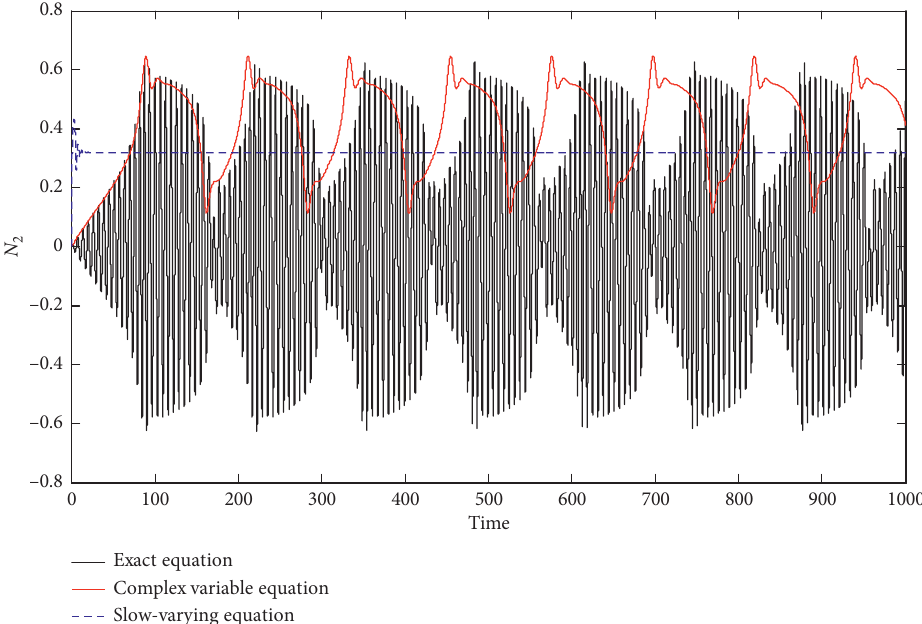
� 0 . 8 ; λ � 0 . 3 ; kn � 5 ; f � 0 . 5. 1 2